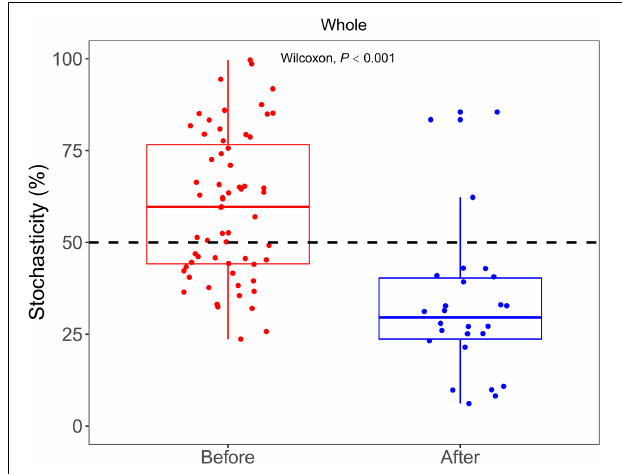
FIGURE 7 | Bar plots show the comparison of NST between the bacterial communities before and after snowfall. The contribution of stochasticity was higher than 50% in the community before snowfall, indicating that the stochasticity process dominates the community assembly processes. The contribution of stochasticity was lower than 50% in the community after snowfall, indicating that the determinism process dominates the community assembly processes. The contribution of stochasticity in cryoconite communities was significantly decreased after snowfall